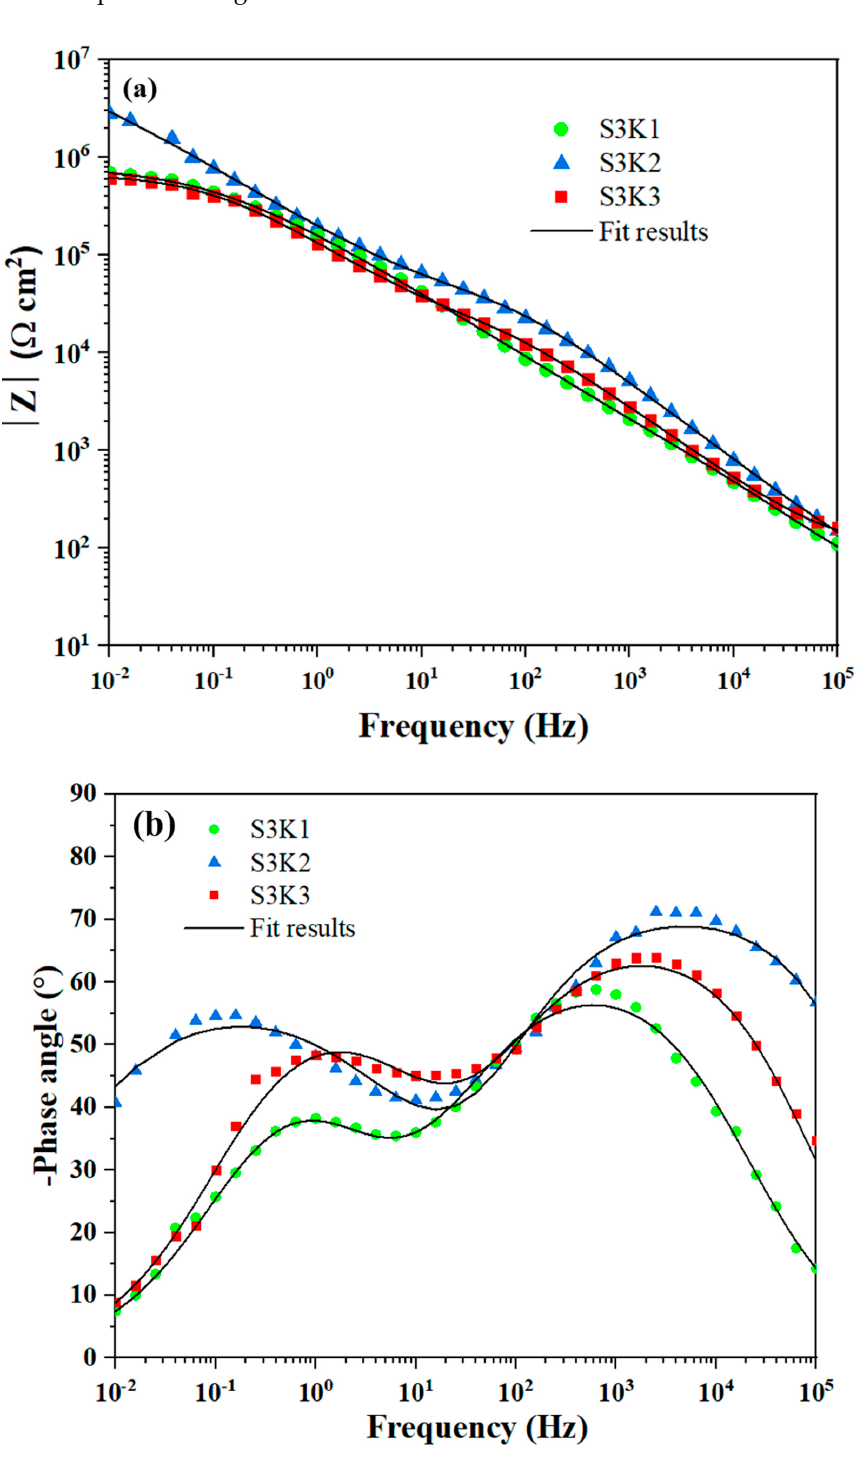
Figure 9. ( a ) Bode magnitude of impedance and ( b ) Bode phase plots of the PEO coatings prepared from coating solutions containing different concentrations of KOH recorded after 24 h immersion in 3.5 wt.% NaCl solution at pH 4.